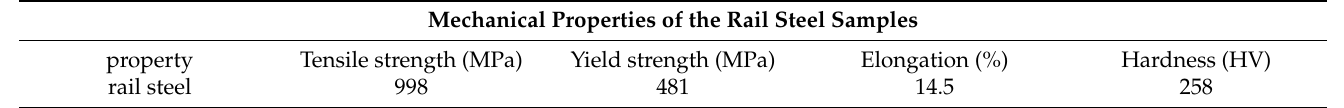
Table 2. Mechanical properties of the investigated steel.